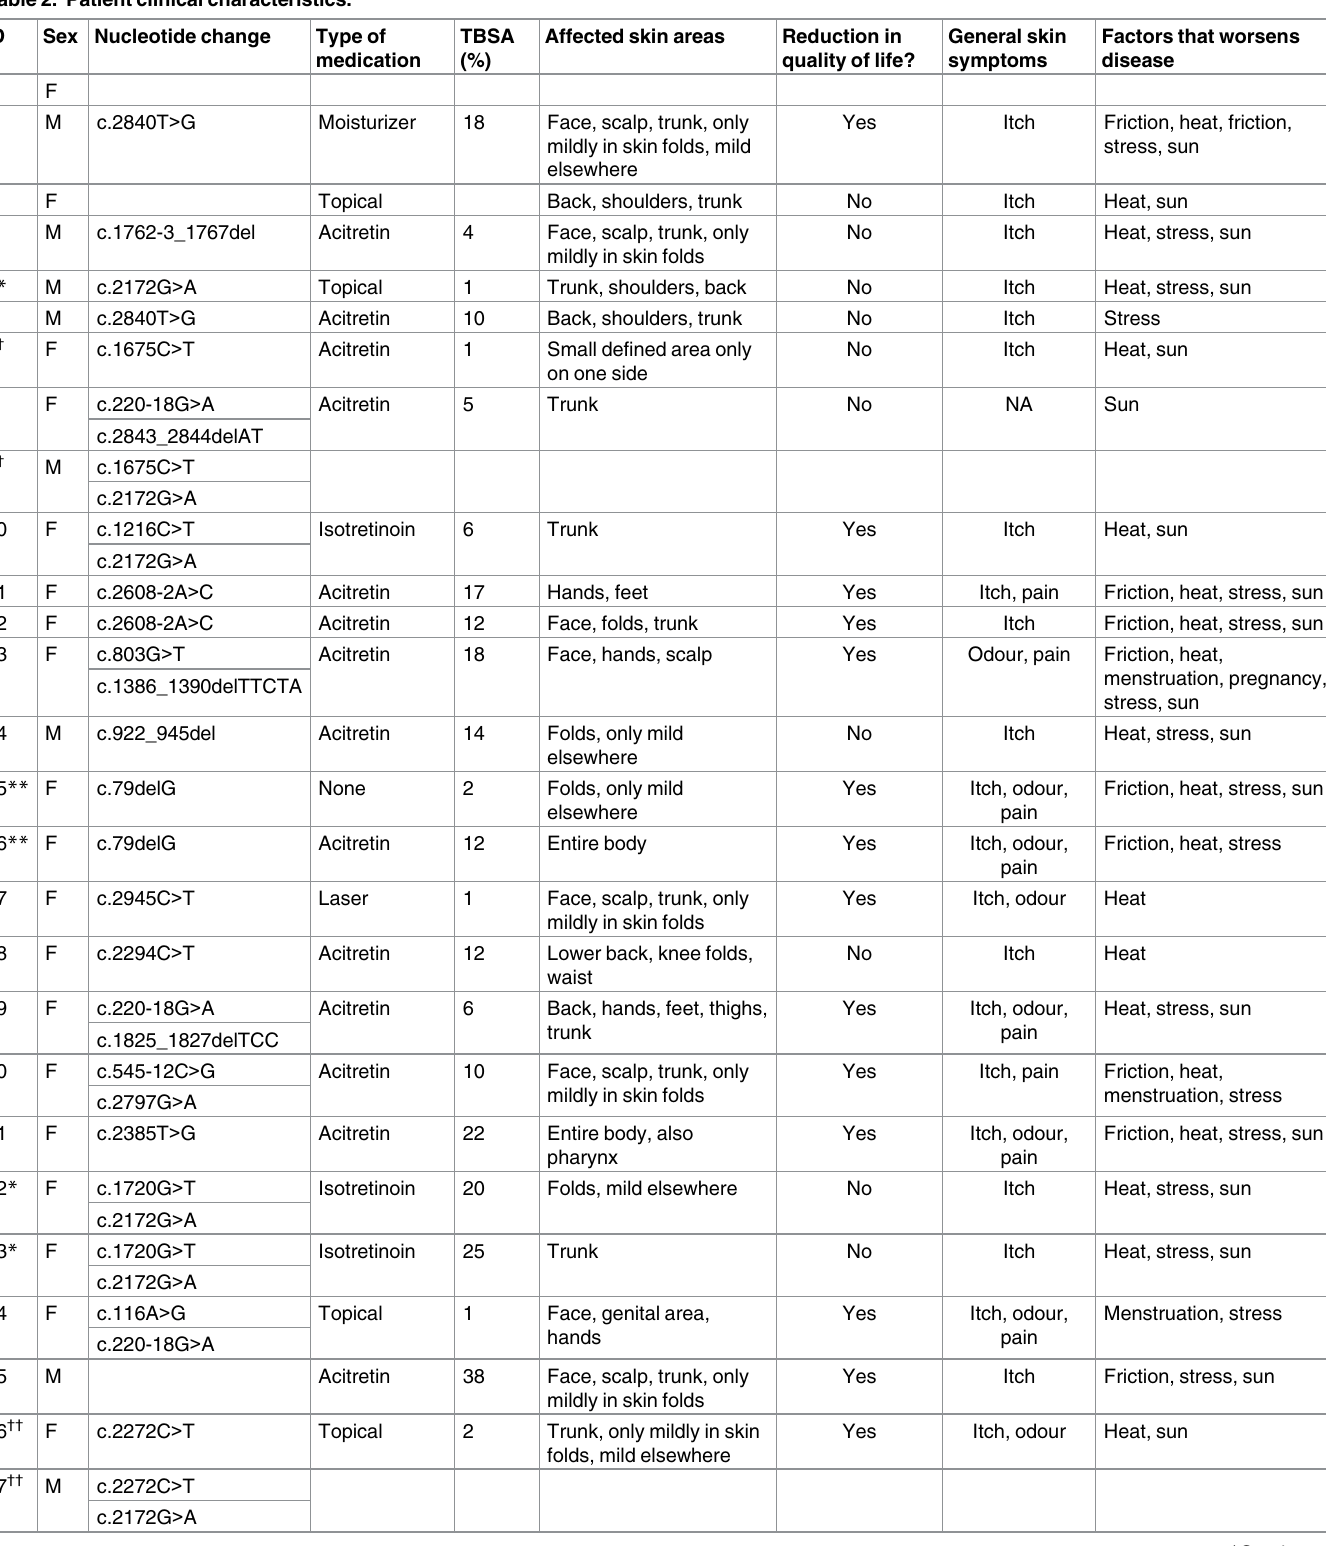
Table 2. Patient clinical